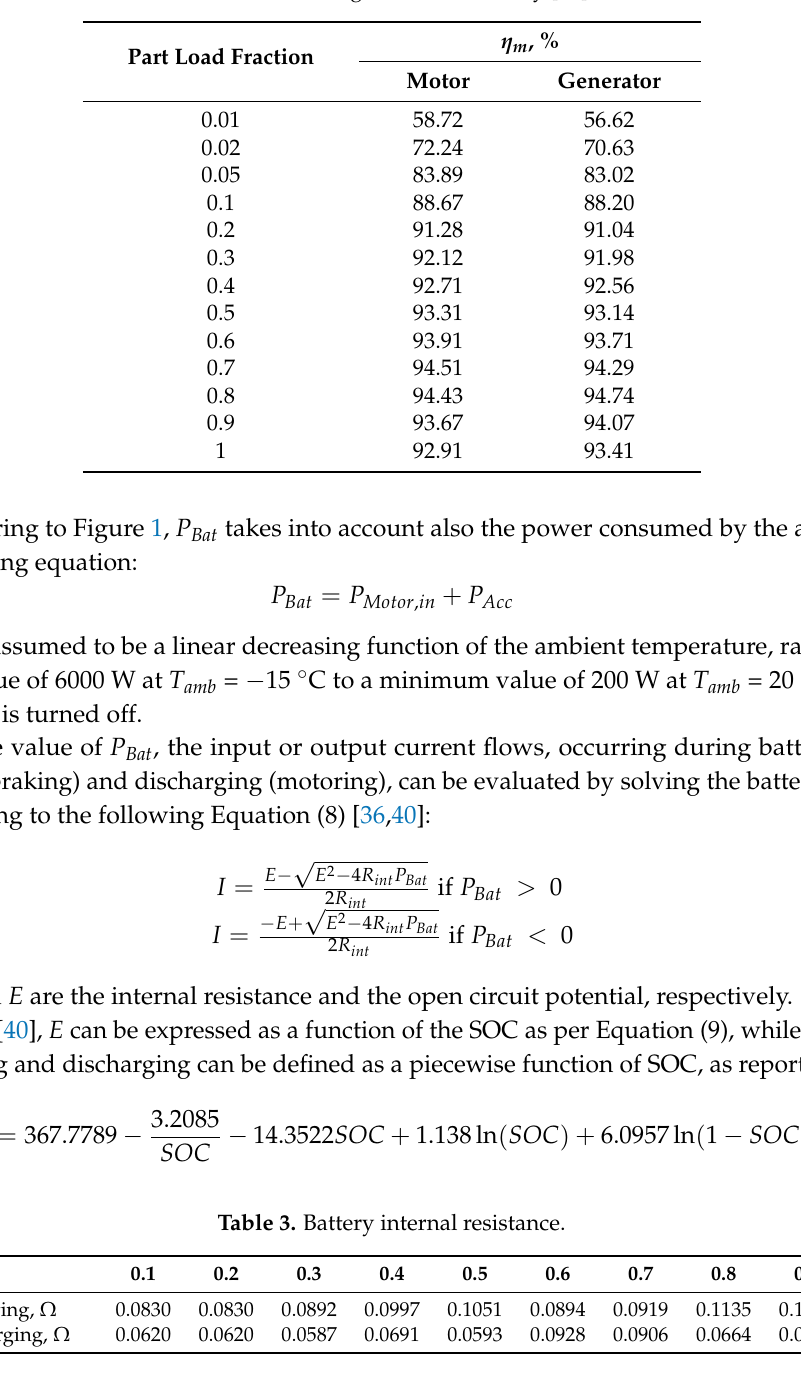
Table 2. Motor/generator efficiency [37].